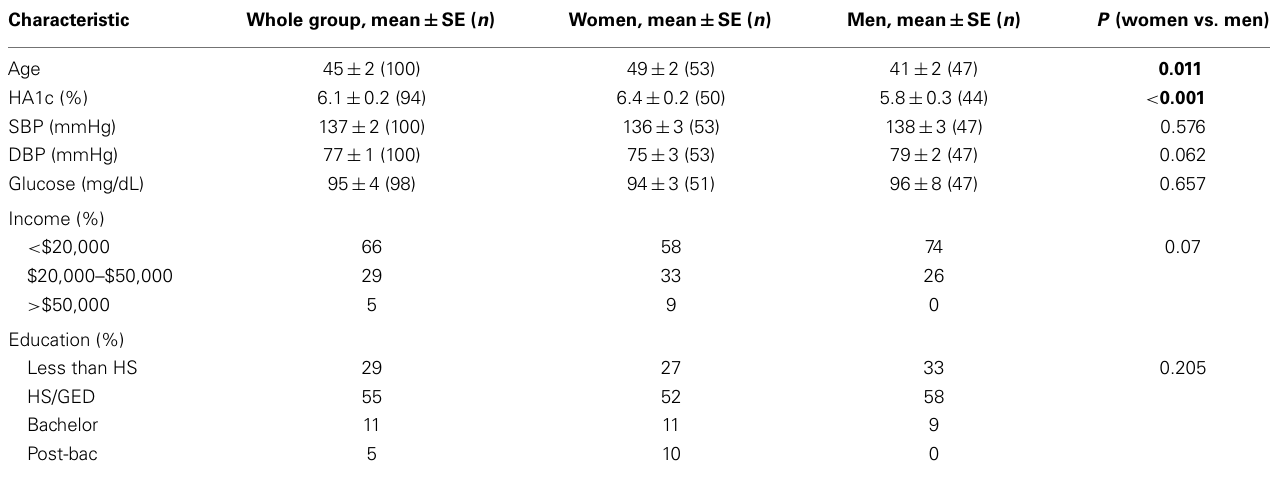
Table 1 | Sample population characteristics .